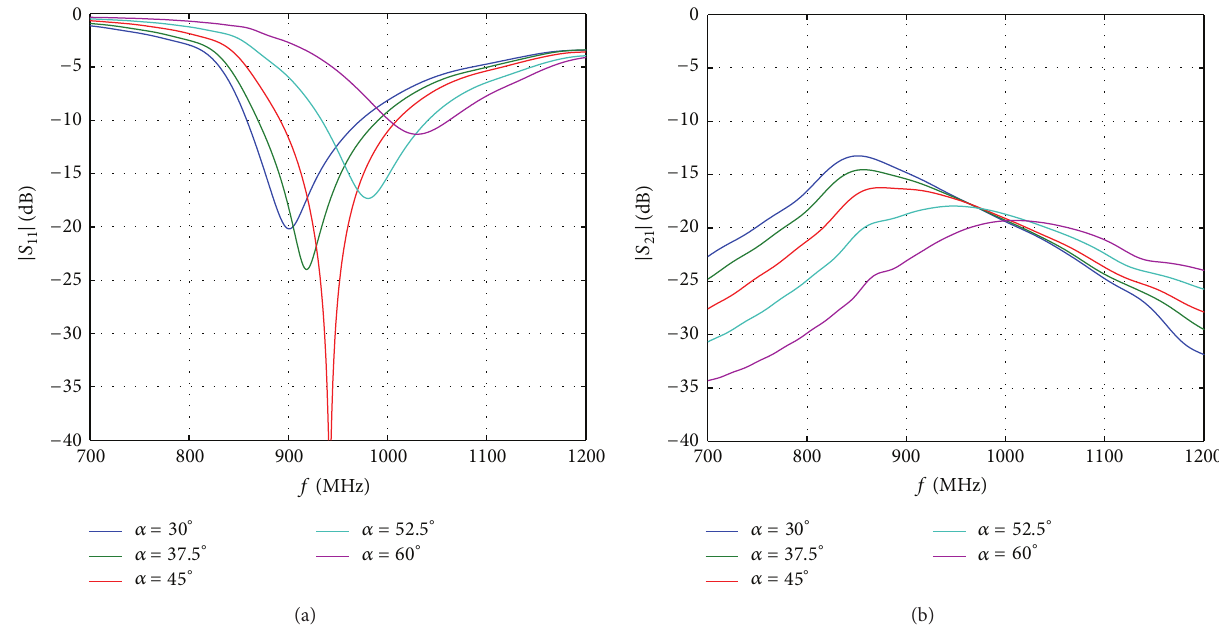
Figure 4: Simulation results for a parametric study of the influence of the flare angle 𝛼 (off the normal dipole axis) for a given interelement distance of 160 mm and fixed dimensions of the dipole arms (a) magnitude of the input reflection coefficient 𝑆 11 and resonance frequency (b) magnitude of the mutual coupling 𝑆 21 between two neighbouring antenna elements.